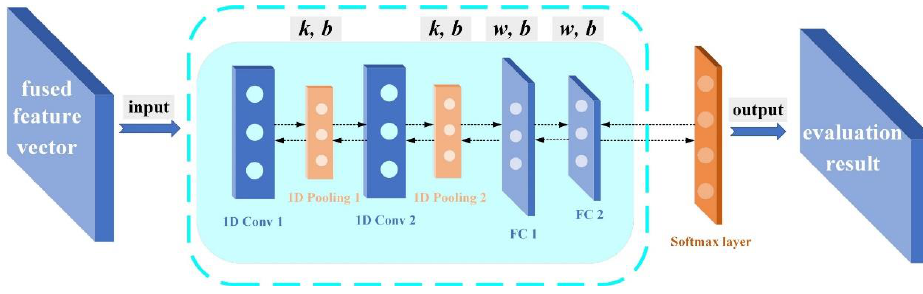
Figure 5. The network structure of 1DCNN.